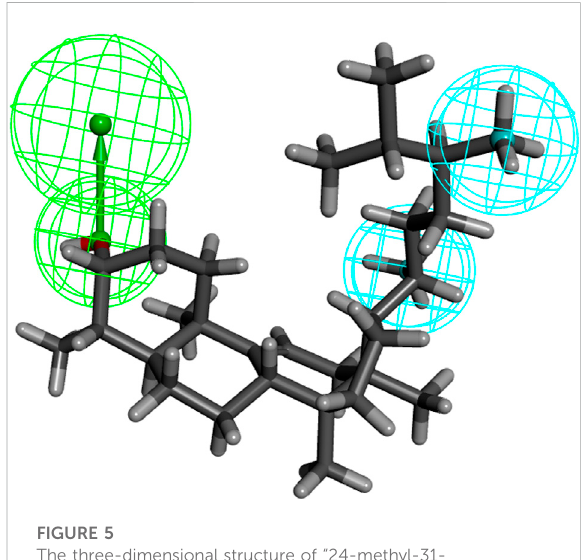
FIGURE 5 The three-dimensional structure of “ 24-methyl-31- norlanost-9(11)-enol ” was used as an example to display “ pharmacophore 01 ” (blue indicates hydrophobic features, green indicates hydrogen bond accepter features).